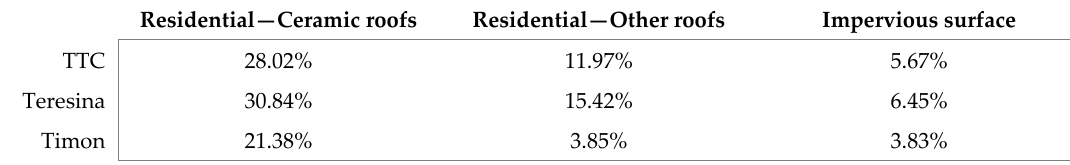
Figure 8. 2019 LULC map derived from Sentinel-2 data. ( A ) TTC urban area. ( B ) Subset showing the central zone of Teresina. ( C ) Subset showing the central zone of Timon. The proportion of LULC thematic classes in the urban area: Residential — Ceramic roofs, Residential — Other roofs, and Impervious surface.